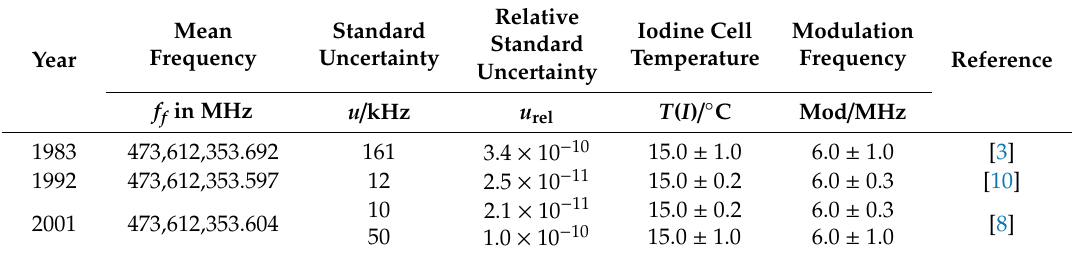
Table 1. Value and uncertainty of the f-dip of an iodine-stabilized laser system in the course of time.